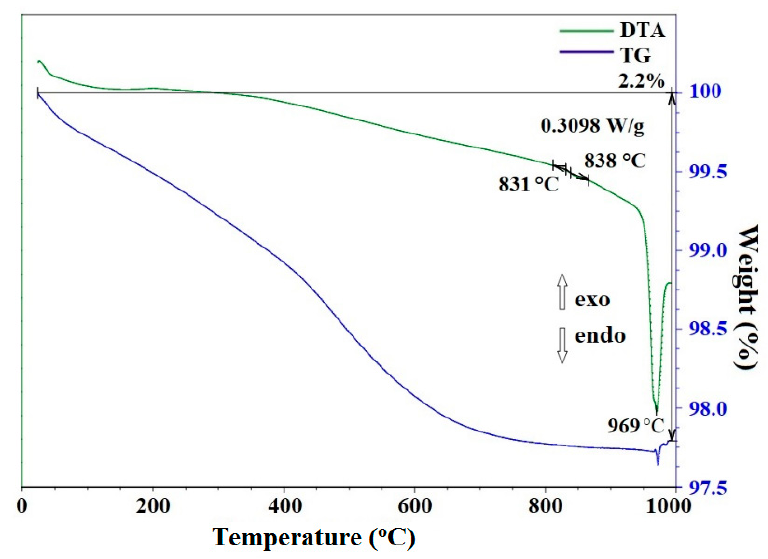
Figure 8. DTA and TG data for sample 5 .